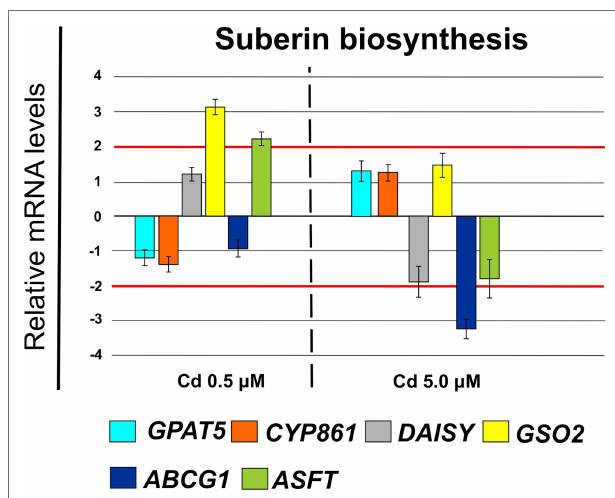
FIGURE 11 | Expression analysis of genes coding for enzymes involved in suberin biosynthesis in Iride roots (15 days from sprouting and from the start of Cd treatments). GPAT5 ( glycerol-3-phosphate acyl transferase 5 ), CYP861 ( cytochrome P450 ), DAISY ( docosanoic acid synthase ), GSO2 ( LRR receptor- like serine/threonine-protein kinase ), ABCG1 ( ATP Binding Cassette Subfamily G Member 1 ), ASFT ( Aliphatic Suberin Feruloyl Transferase ). Red lines highlight the fold changes 2 and − 2 to graphically identify the genes differentially